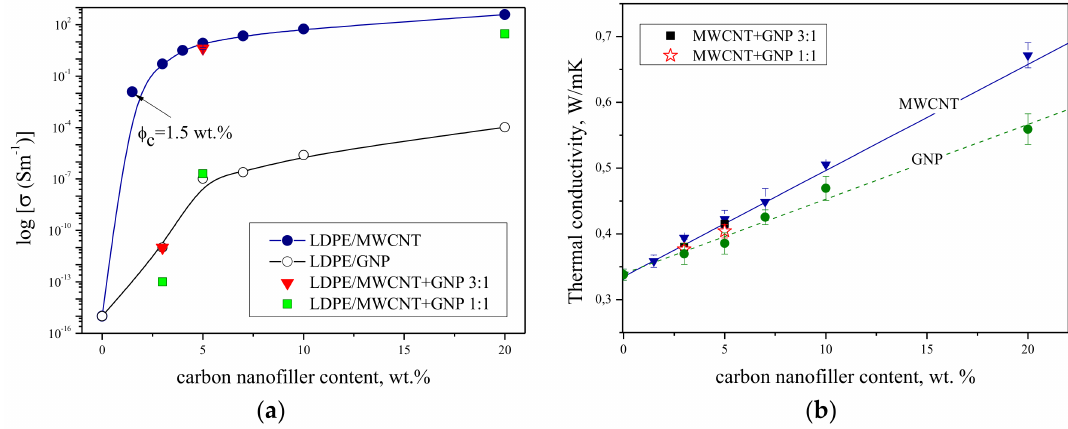
Figure 3. ( a ) The electrical conductivity and ( b ) the thermal conductivity vs. nanofiller content (wt. %) of LDPE/MWCNTs, LDPE/GNPs and LDPE/MWCNTs + GNPs